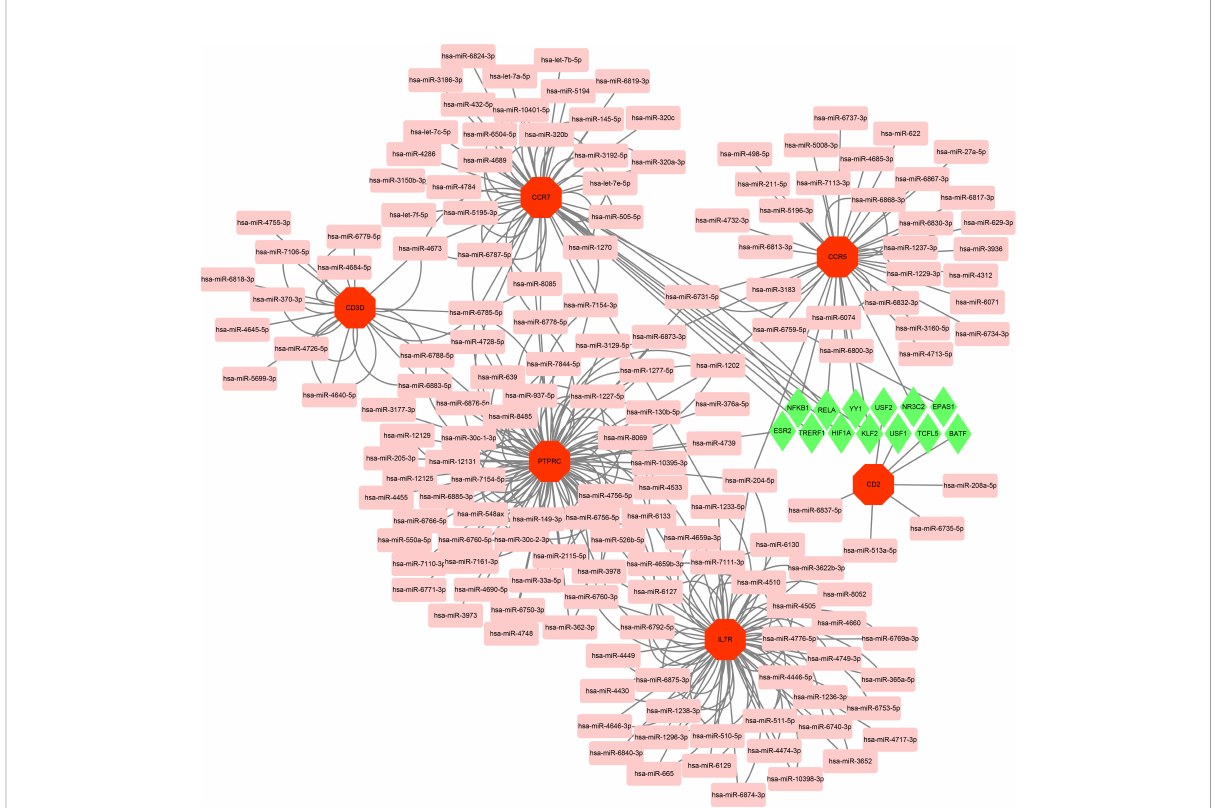
FIGURE 9 Based on MiRwalk and TRRUST database, TF-mRNA – miRNA regulation network of hub genes was constructed using Cytoscape. Hub genes were marked in red octagon; miRNAs were marked in pink round rectangle; TFs were marked in green